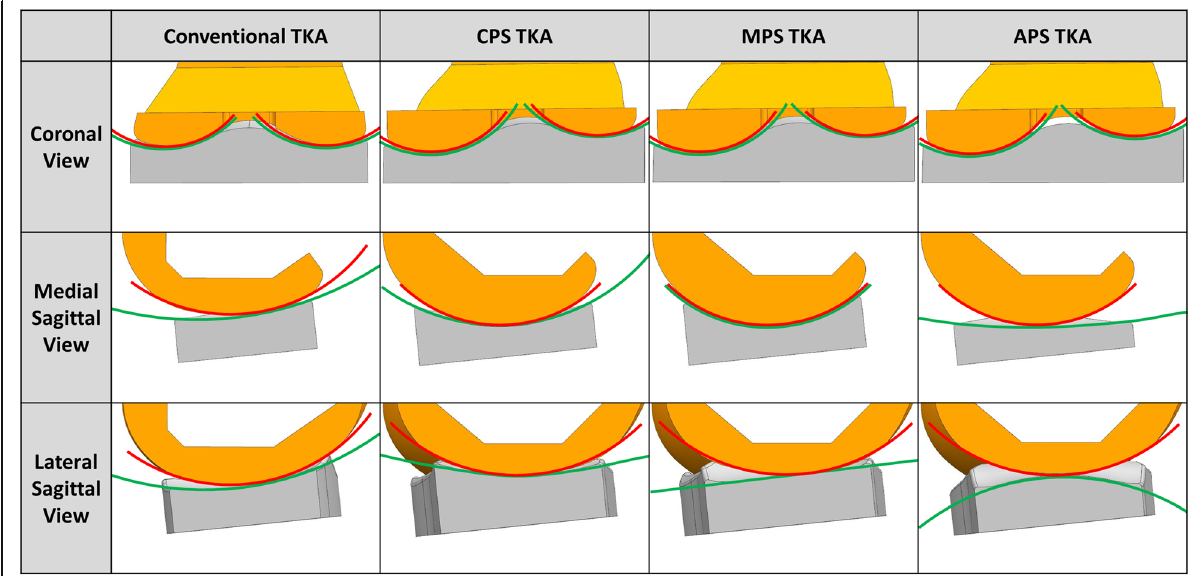
Fig. 2 Cross sections of conventional TKA and patient-specific TKAs with three different articular surface